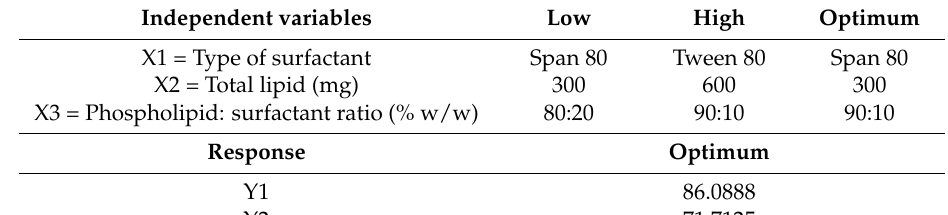
Table 6. Composition of factors and response for the optimized MIC Transfersomes.